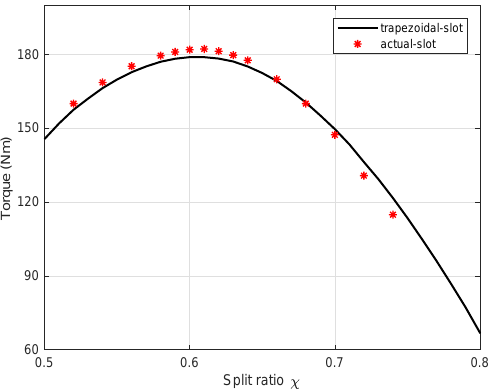
Figure 9. Torque versus split ratio comparison between the SynRMs with simplified “trapezoidal- shape” slot and “actual-shape”